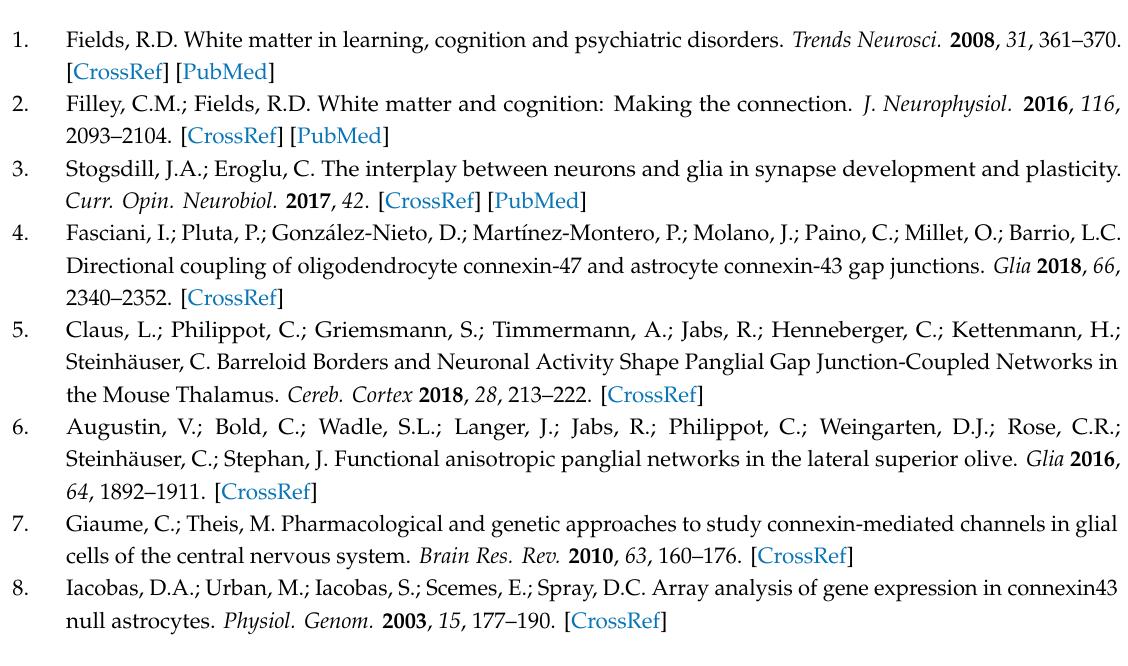
Table S1: Genes whose > 1.5 × absolute fold-change did not meet the individual CUT criterion. Red / green background of the expression ratio indicates not significant (false) up- / down-regulation. Table S2: Genes considered as significantly up-regulated although their absolute fold-change was below the traditional 1.5 × . Table S3: Genes considered as significantly down-regulated although their absolute fold-change was below the traditional 1.5 × . Figure S1: MAG-labeled phase contrast micrographs showing the morphological changes of Oli-neu cells cultured alone (CTR) and co-cultured with astrocytes (INS). Figure S2: Presence of non-touching precursor oligodendrocytes regulate the actin cytoskeleton (AC) pathway. Figure S3: Presence of non-touching precursor oligodendrocytes regulates the Circadian Rhythm (CR)